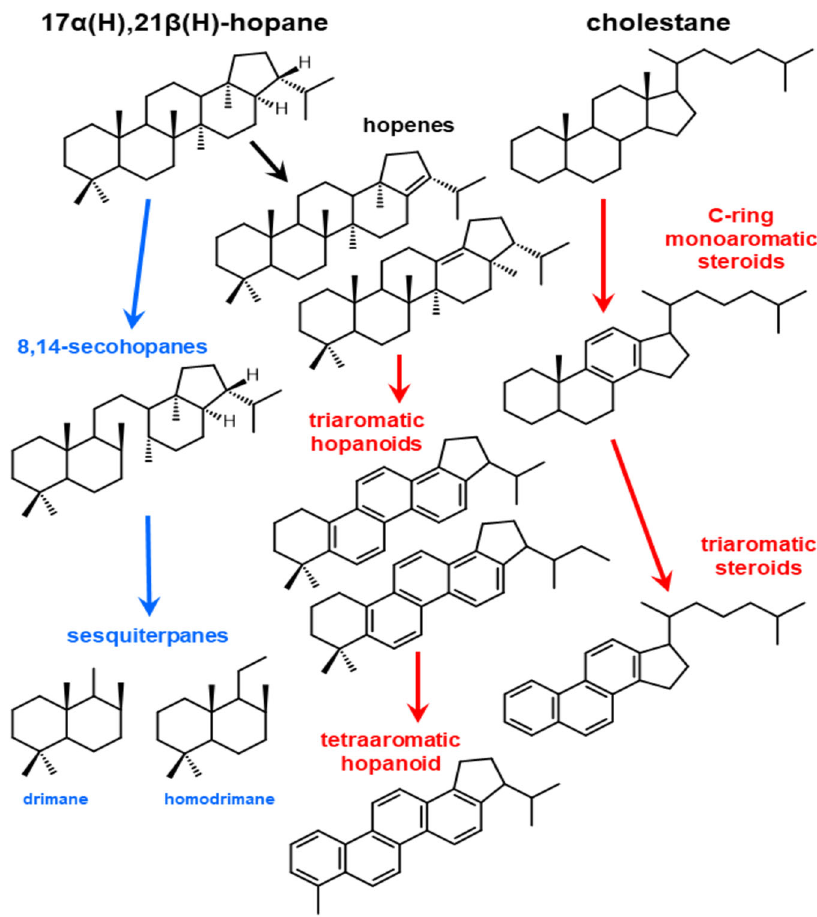
Fig. 5 Overview of hopane and sterane biodegradation and oxidation pathways in Guaymas Basin organic-rich sediments. The molecules 17 α (H),21 β (H)-hopane and cholestane were used as model compounds. Blue arrows indicate microbial biodegradation transforming hopanoids to sesquiterpanes, and red arrows indicate abiotic oxidation to form aromatized hopanoid and steroid